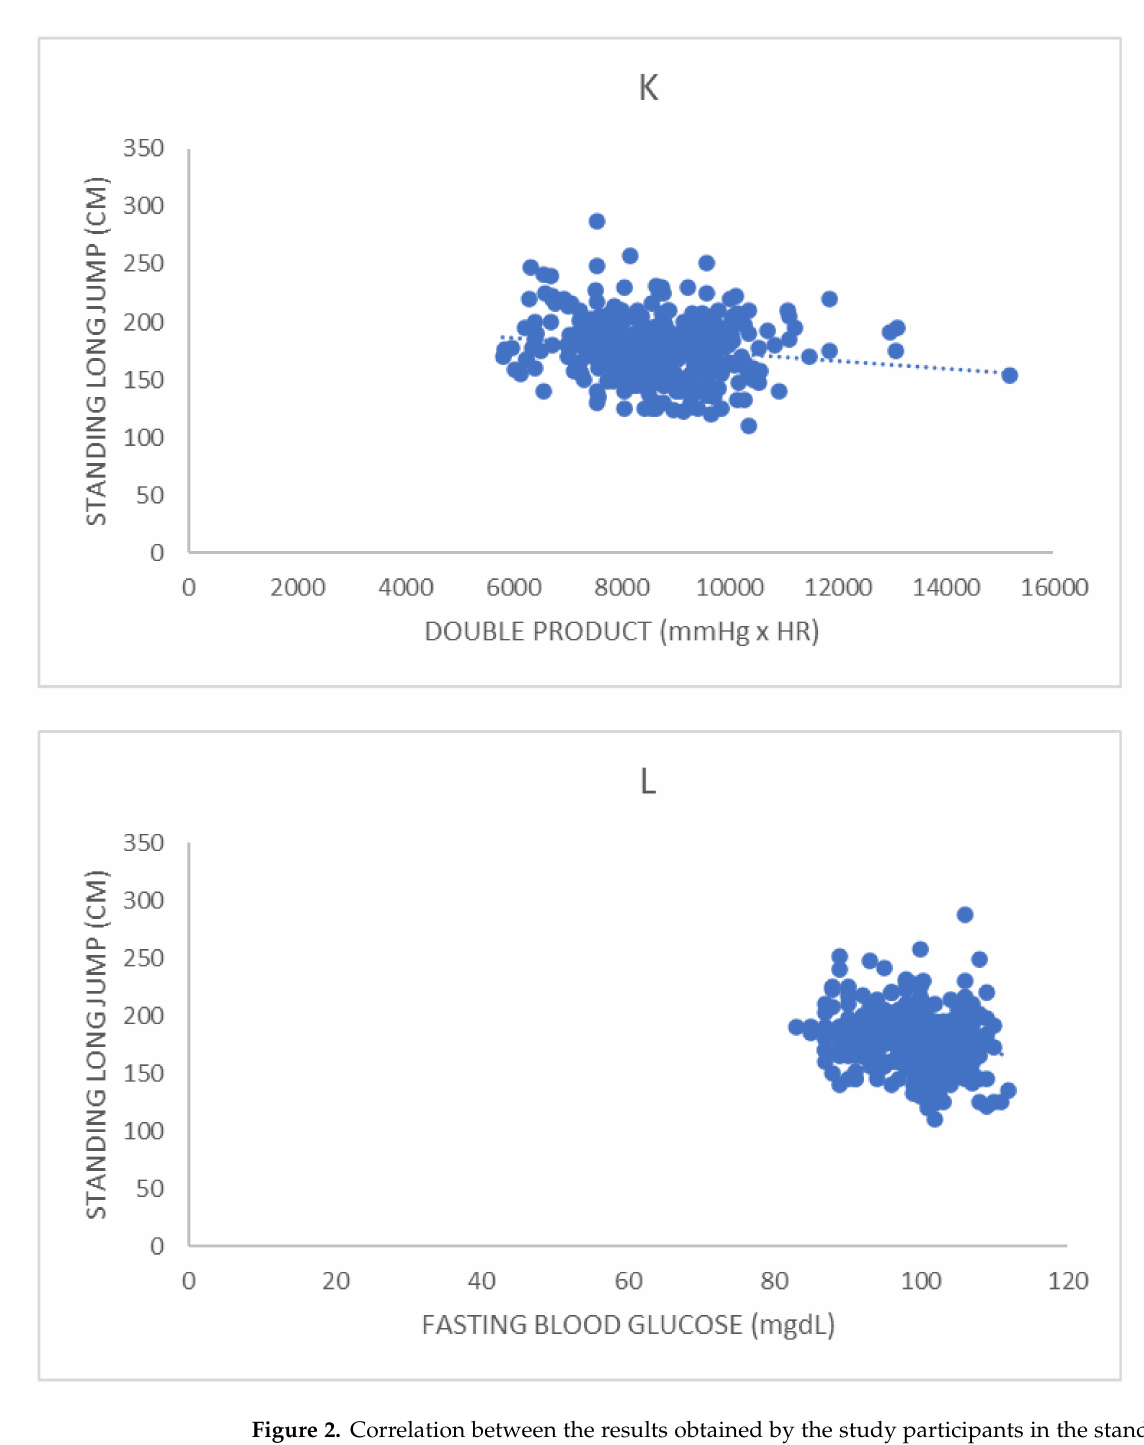
Figure 2. Correlation between the results obtained by the study participants in the standing long jump test and the anthropometric and health variables with which it maintained a significant cor- relation: ( A ) weight; ( B ) height; ( C ) body mass index; ( D ) body fat percentage; ( E ) lean body mass; ( F ) abdominal girth; ( G ) waist-to-hip ratio; ( H ) systolic blood pressure; ( I ) diastolic blood pressure; ( J ) average blood pressure; ( K ) double product; ( L ) fasting blood